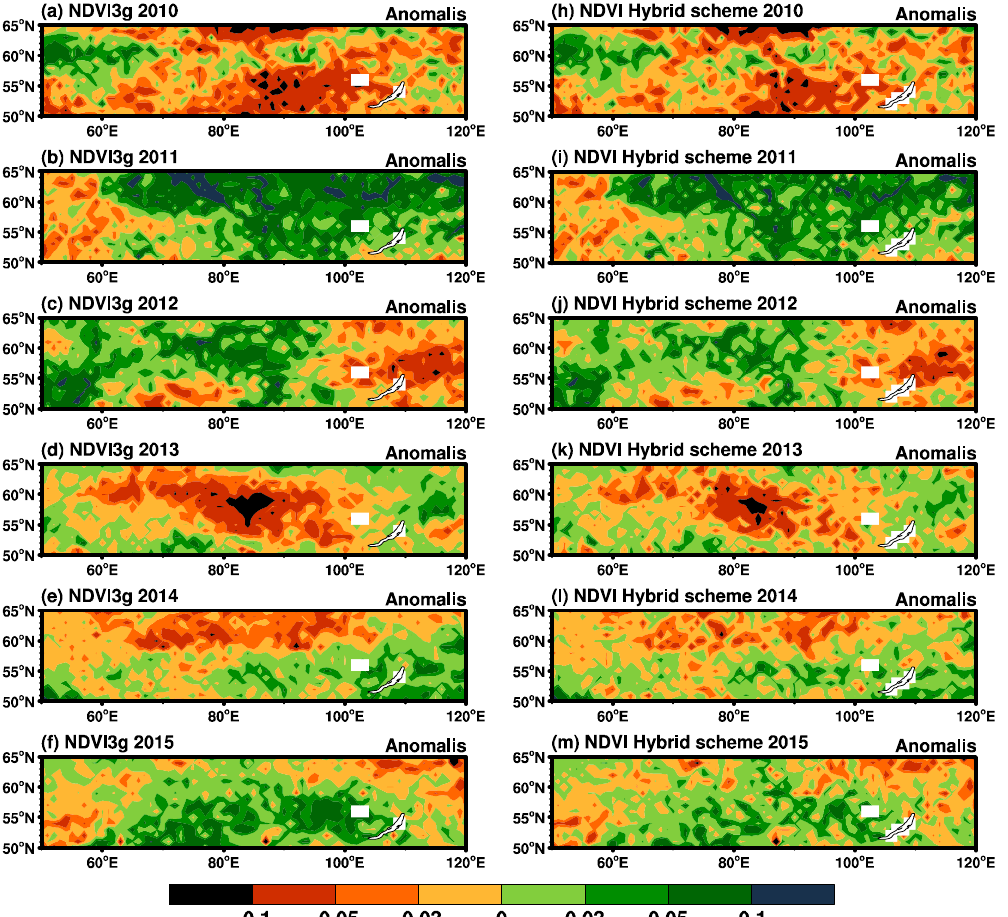
Figure 10. Spring (April–May–June (AMJ)) NDVI anomalies over Eurasia during 2010–2015, where ( a – f ) are from the NDVI3g data and ( h – m ) are from the independent hindcast results of the hybrid scheme.